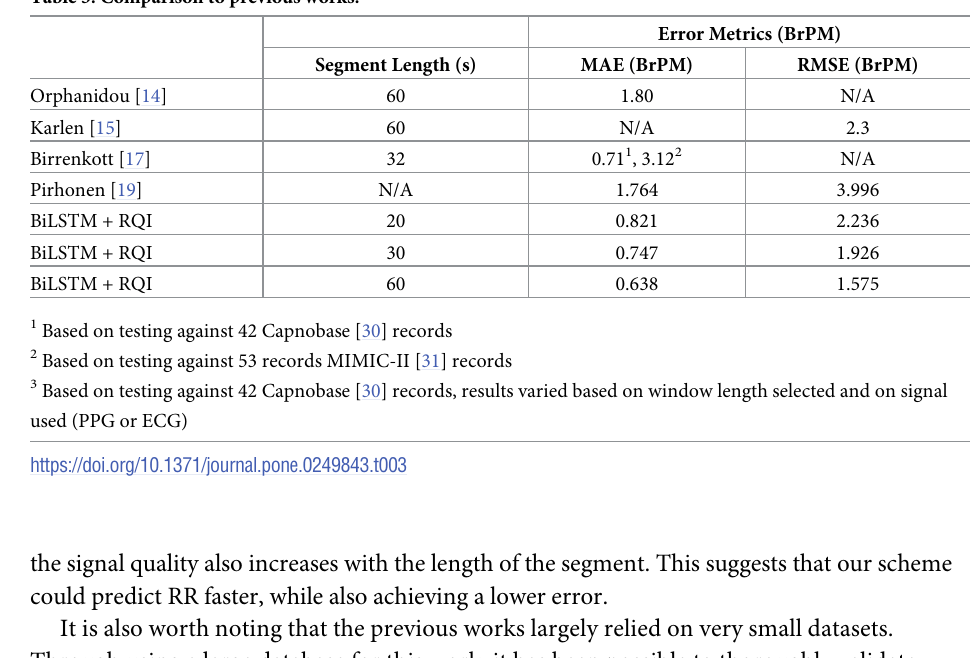
Table 3. Comparison to previous